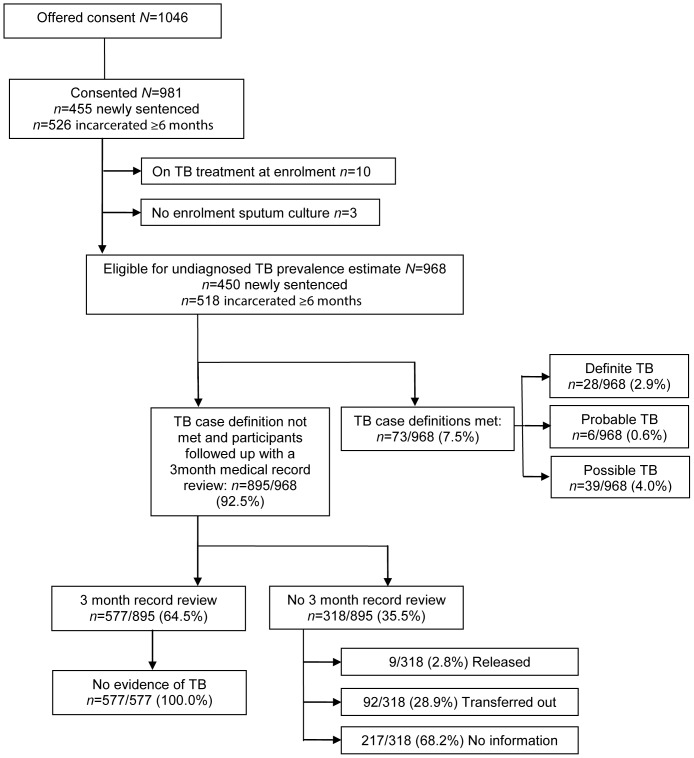
Study inclusions, losses to follow-up and tuberculosis outcomes.TB = Tuberculosis.